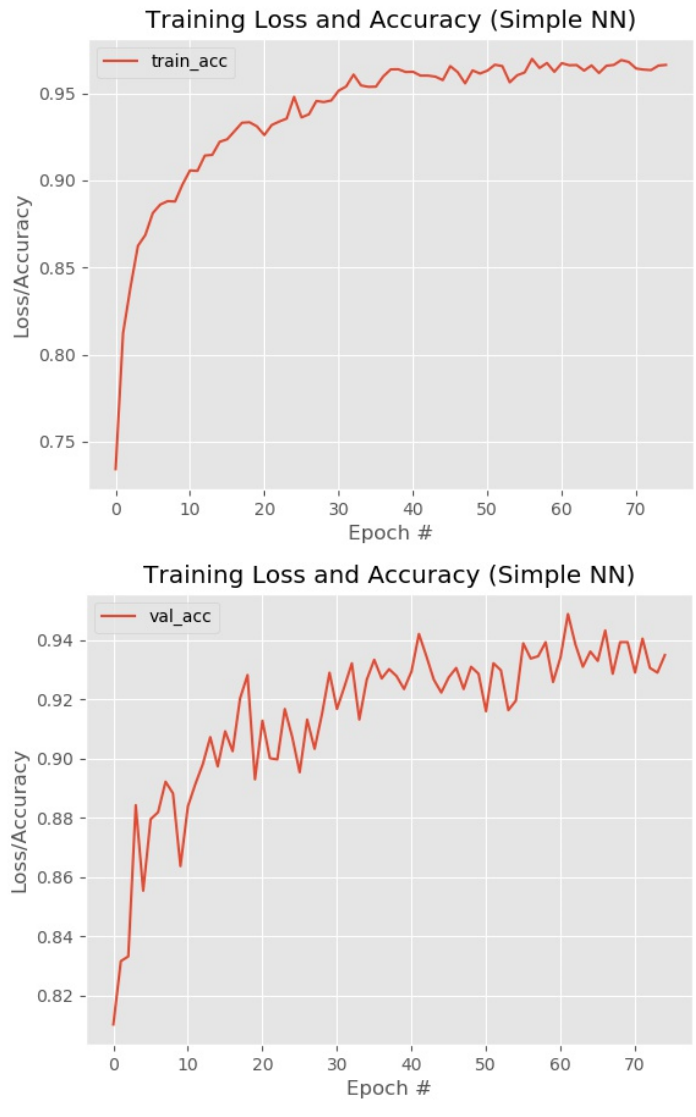
Figure 6. Training and validation accuracy graph curves for the proposed